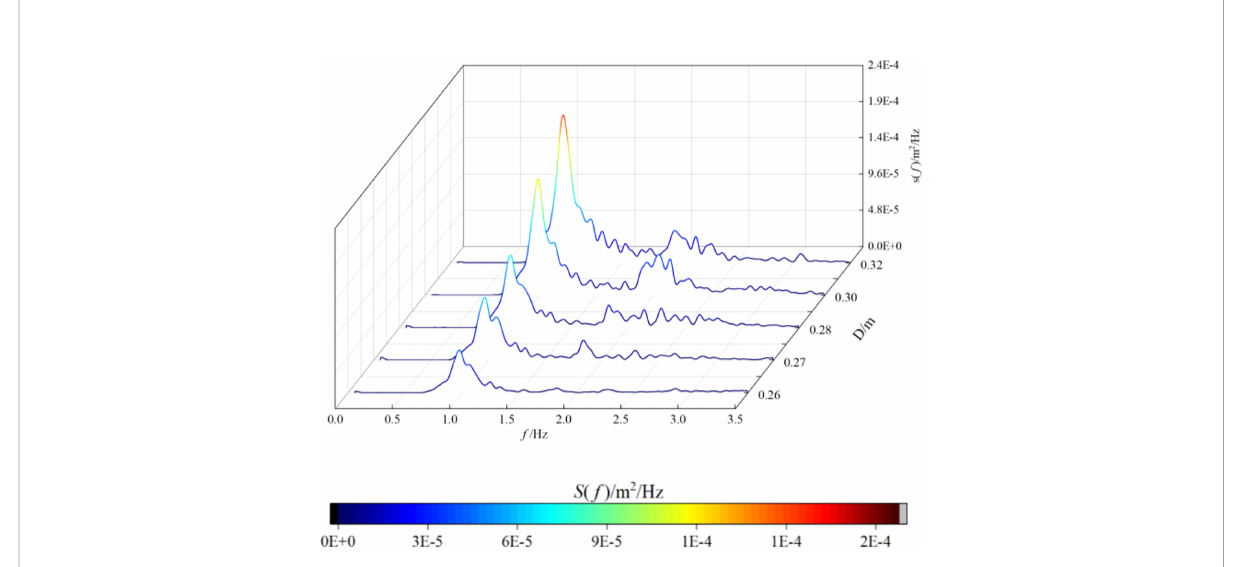
FIGURE 8 Comparison of wave energy spectra under different water depths (M1, H i = 0.043 m, T = 1 s, x = 1.5